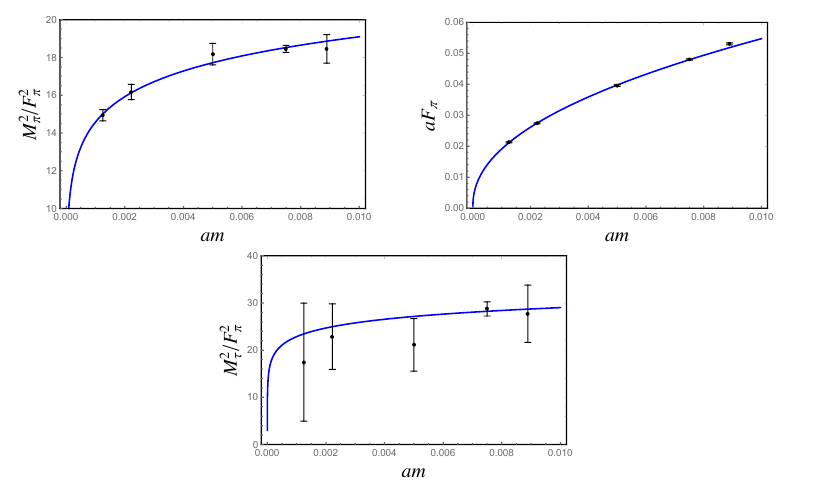
Figure 2. M 2 ⇡ / F 2 ⇡ , aF ⇡ and M 2 ⌧ / F 2 ⇡ as a function of the bare fermion mass in lattice units, am. Taken from Ref.